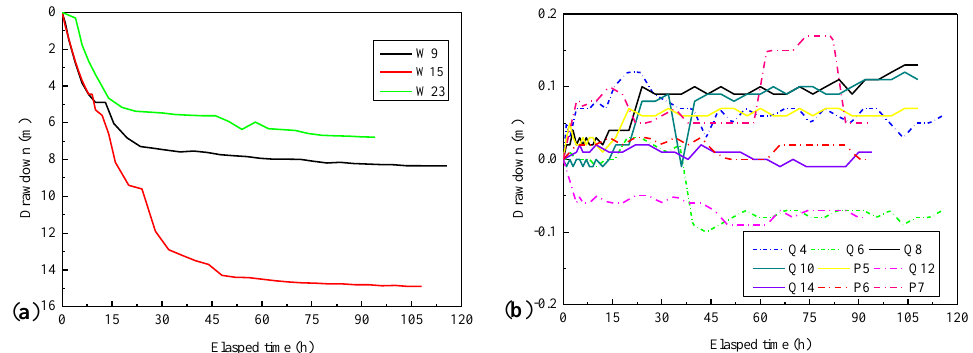
Figure 11. Variation of the drawdown measured in observation wells: ( a ) inside the excavation; and, ( b ) outside the excavation.